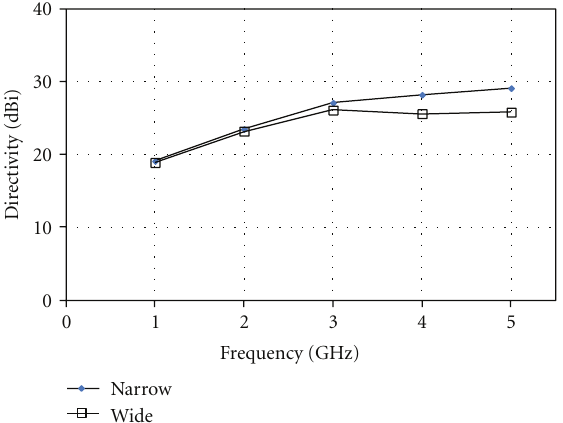
Figure 12: E ffi ciencies of a narrow throat antenna ( N e = 4) approach unity as the frequency